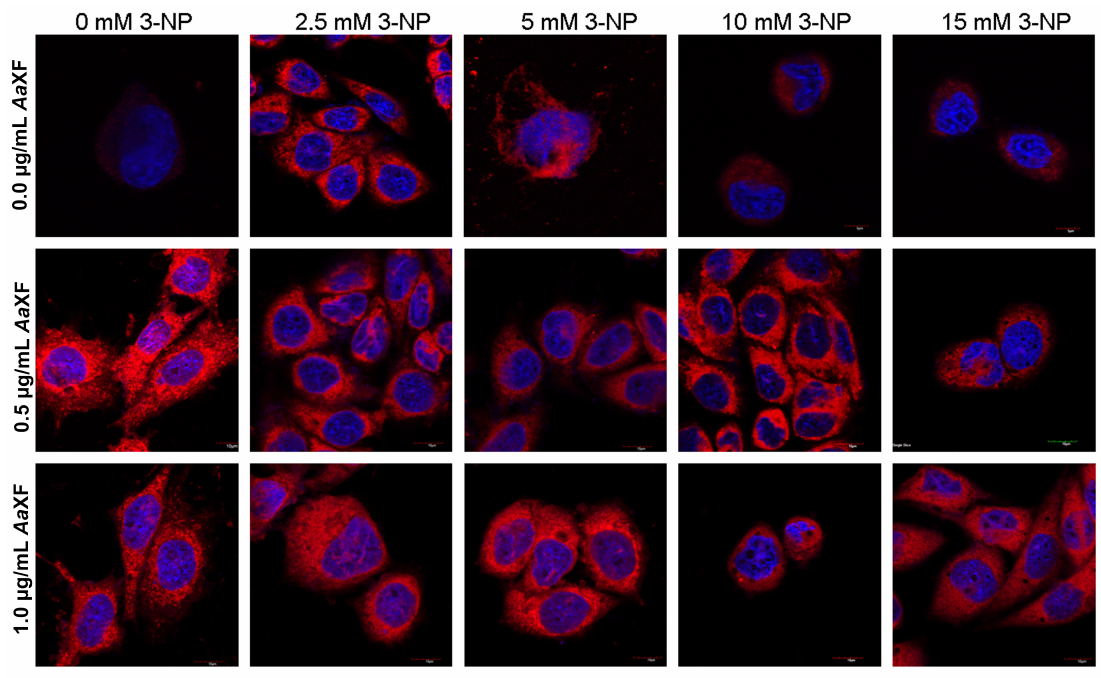
Figure 6. Confocal fluorescence analysis using MitoTracker ® Deep Red FM and DAPI of PC12 cells cultured in RPMI with added plant extract (pre-incubation) followed by incubation with the xanthone fraction of Anemarrhena asphodeloides (0.5, 1 µ g / mL) and 3-NP (2.5, 5, 10 and 15 mM). Scale bar = 10 µ m.